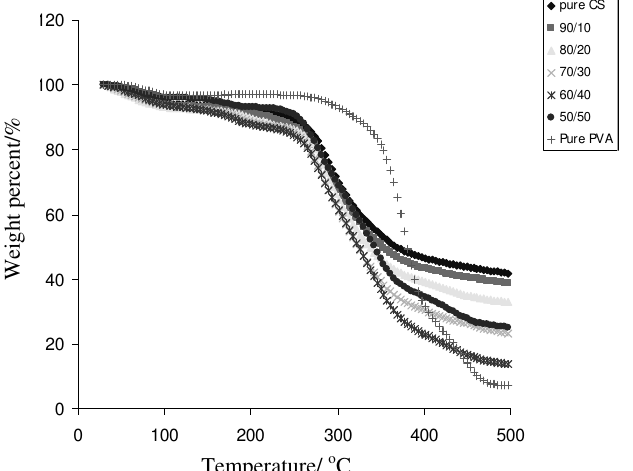
Figure 3. TGA thermograms of pure CS film, pure PVA film and their blended films having various